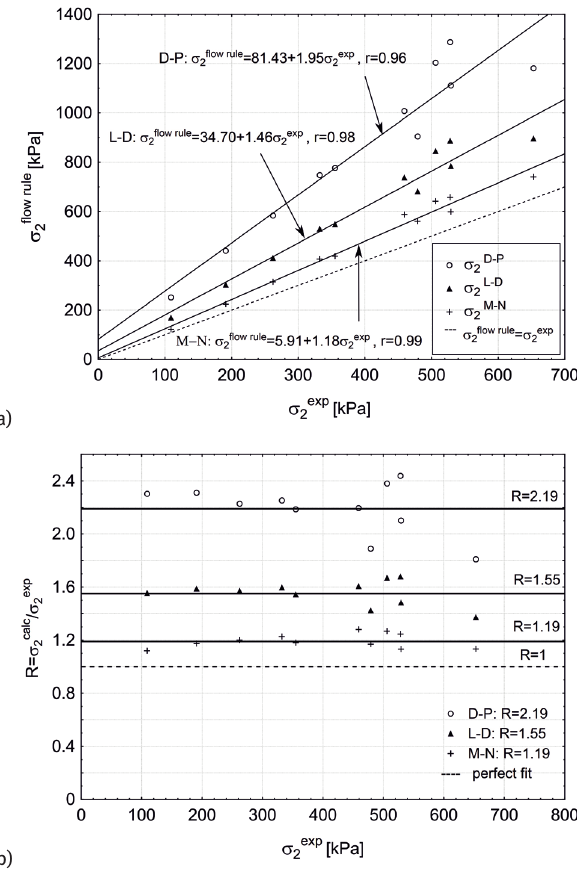
, obtained for Drucker–Prager Figure 14: The intermediate stress s 2 (D-P), Matsuoka–Nakai (M-N) and Lade–Duncan (L-D) failure criteria, assuming plane strain condition and the associated flow rule, as function of the measured s (Table 3): (a) s 2calc ( s 2exp ) and (b) R( s 2exp ) , 2 where R = s 2calc / s 2exp .